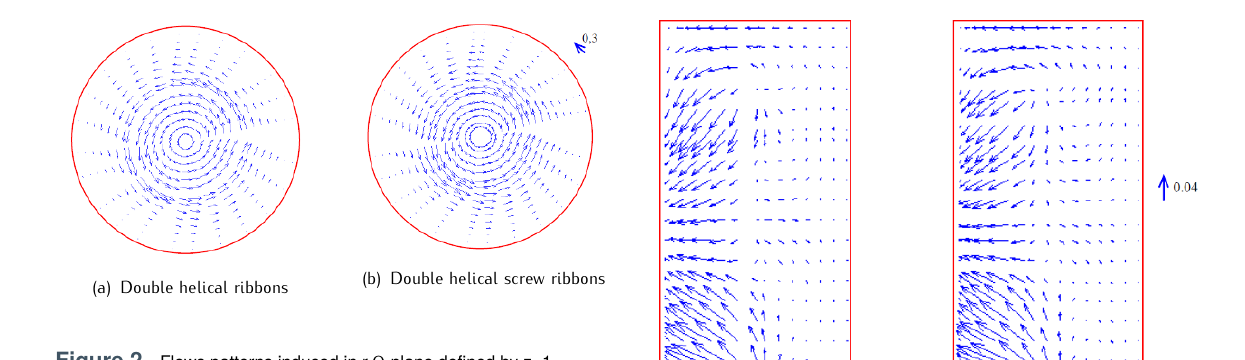
Θ plane defined by z=1.